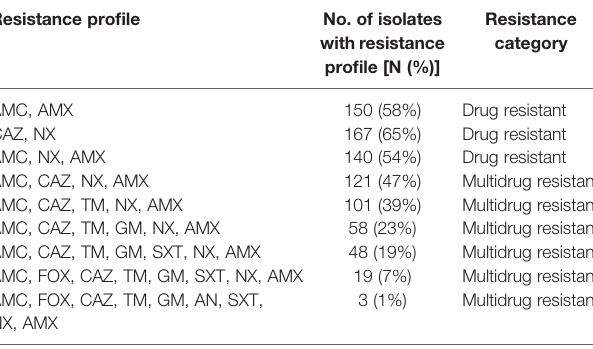
TABLE 3 | Multidrug resistant pro fi le of ESBL-EC isolates.